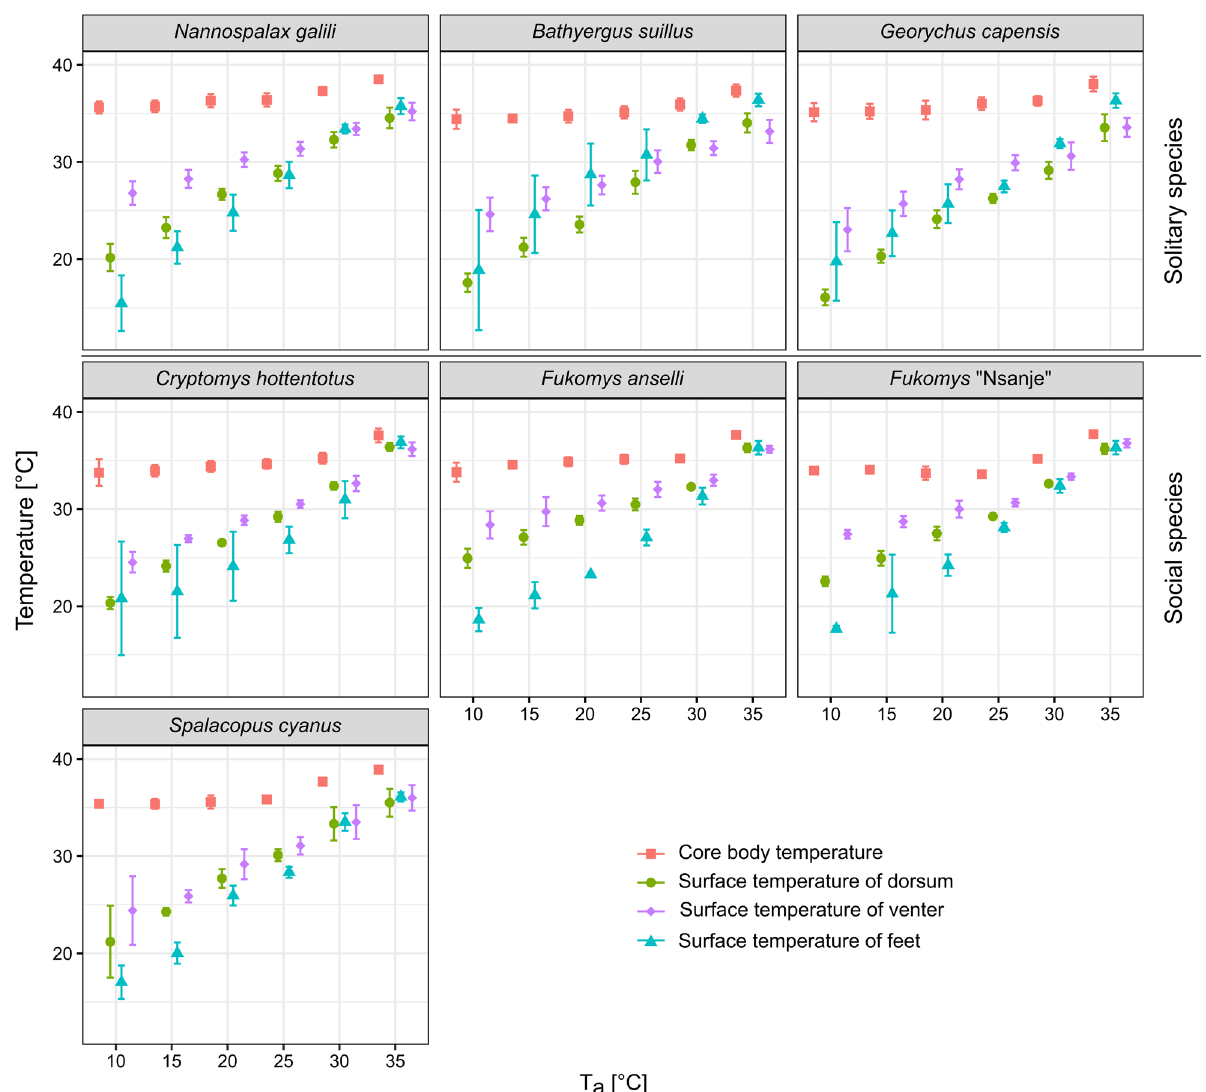
Figure 2. Core body temperatures and surface temperatures of the dorsum, the venter, and the feet measured across the range of ambient temperatures in seven subterranean rodent species. Means ± SD are depicted. The figure was prepared using the program Inkscape 0.92 (https ://inksc